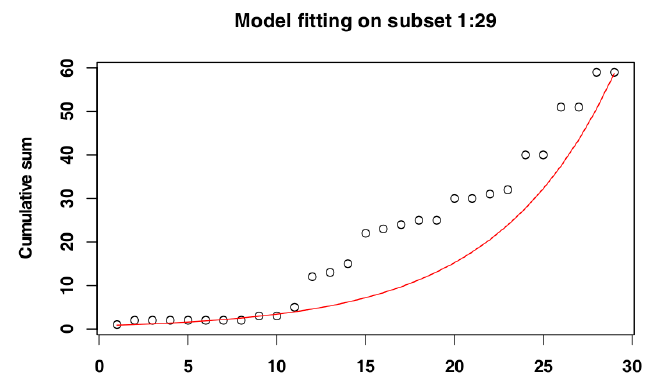
Figure 5. Model fitting for the selected subset for Czech Republic data.